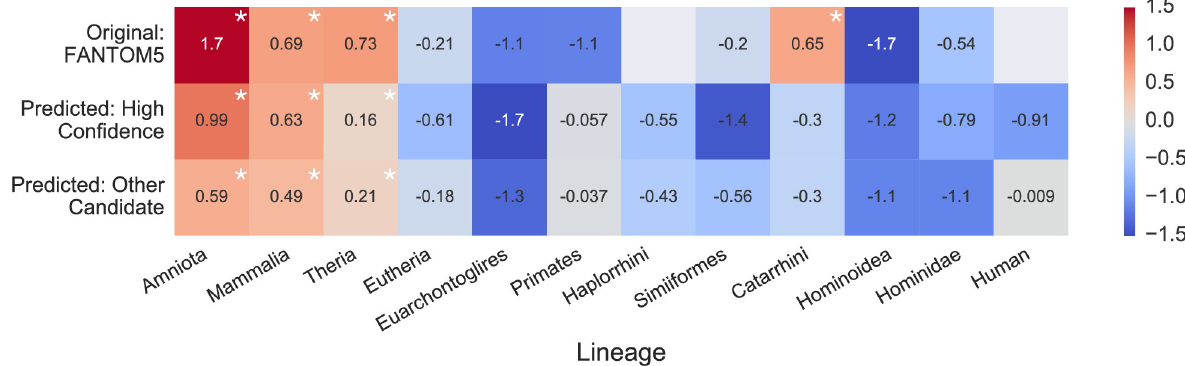
Fig 5. Validated and predicted placental enhancers are enriched for ancient transposable elements. We computed the enrichment for overlap of transposable elements (TEs) with origins on different lineages for experimentally validated and predicted enhancer sets. The enrichment was computed in reference to the mean of the genome-wide overlap observed in 1,000 (predicted) or 10,000 (FANTOM5) permuted enhancer sets. The log 2 of the relative change is given for each comparison. Asterisks indicate significant enrichment ( P < 0.05, randomization test). Empty gray boxes indicate there were not enough enhancers and TEs of a given origin to test for